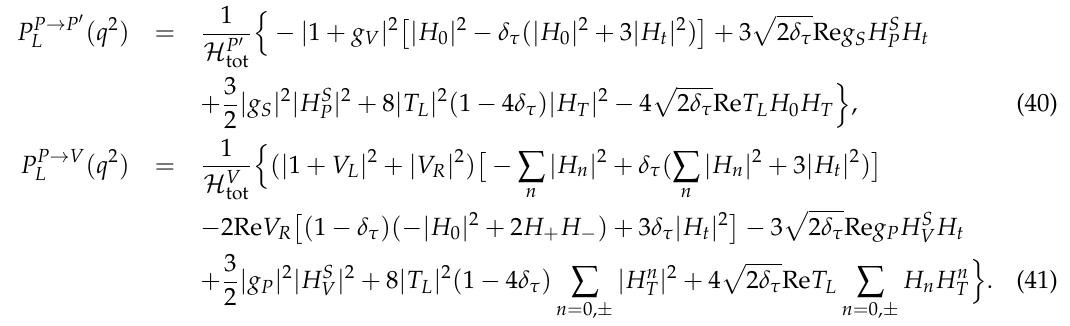
( q 2 ) ( left ) and R ( q 2 ) ( right ) in the tensor scenario. The black dashed Figure 6. Differential ratios R η J / ψ c lines are the SM predictions; the gray bands include NP effects corresponding to the 2 σ allowed regions in Figure 5; the red dot-dashed lines represent the best-fit value of the corresponding NP coupling given in Equation